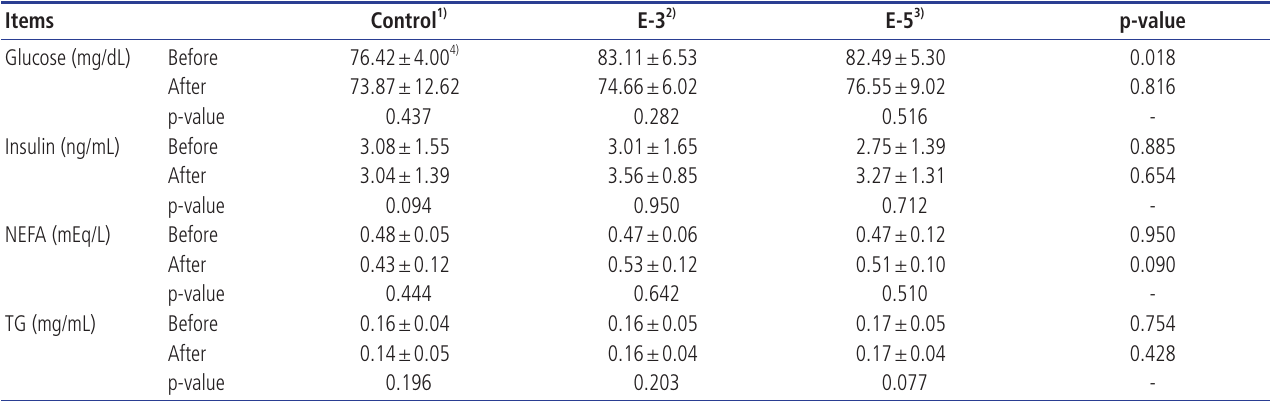
Table 6. Effects of feeding ethanol on serum glucose, insulin, non-esterified fatty acid, and triglyceride content of finishing Korean cattle (Hanwoo) steers Items